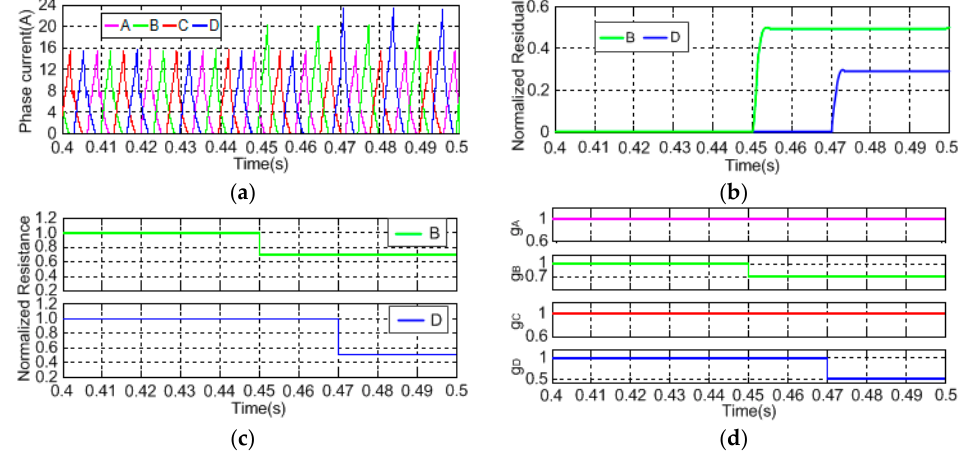
Figure 7. Simulation results in case of multiphase ISCF with high speed and variable loading. ( a ) four-phase currents; ( b ) normalized residual; ( c ) normalized resistance; and ( d ) diagnostic variable g n .